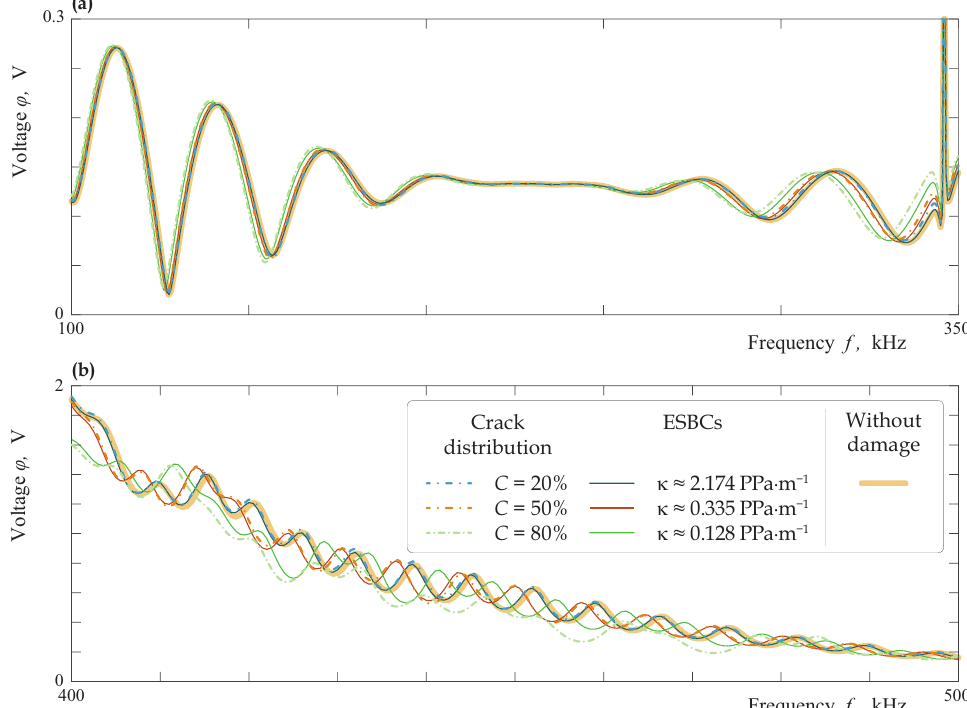
Figure 17. Voltage | ϕ | ( f ) sensed by PWAT at the surface of the two-layered laminate with interfacial damaged zone of length w = 40 mm modelled as an array stochastically (dash-dotted lines) and via the ESBCs (thin solid lines) at lower ( a ) and higher ( b )